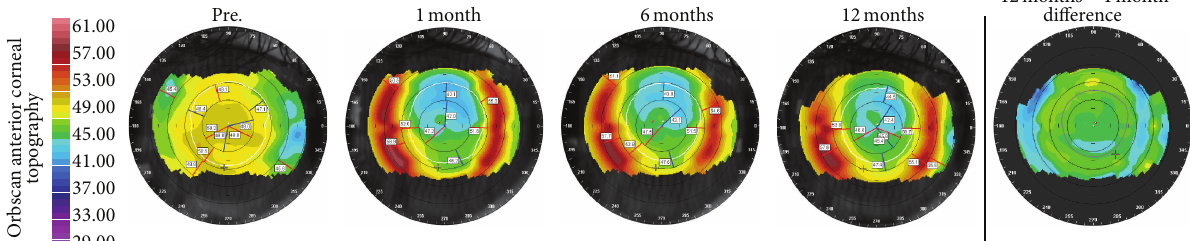
Figure 4: Orbscan anterior topography (Baush & Lomb) over 12-month postoperative course after SMILE Xtra for 26-year-old female with preoperative SE − 7.62 D and CCT 478 𝜇 m in right eye. (Randleman ectasia risk score: 4) (SE: spherical equivalent) (CCT: central corneal thickness).